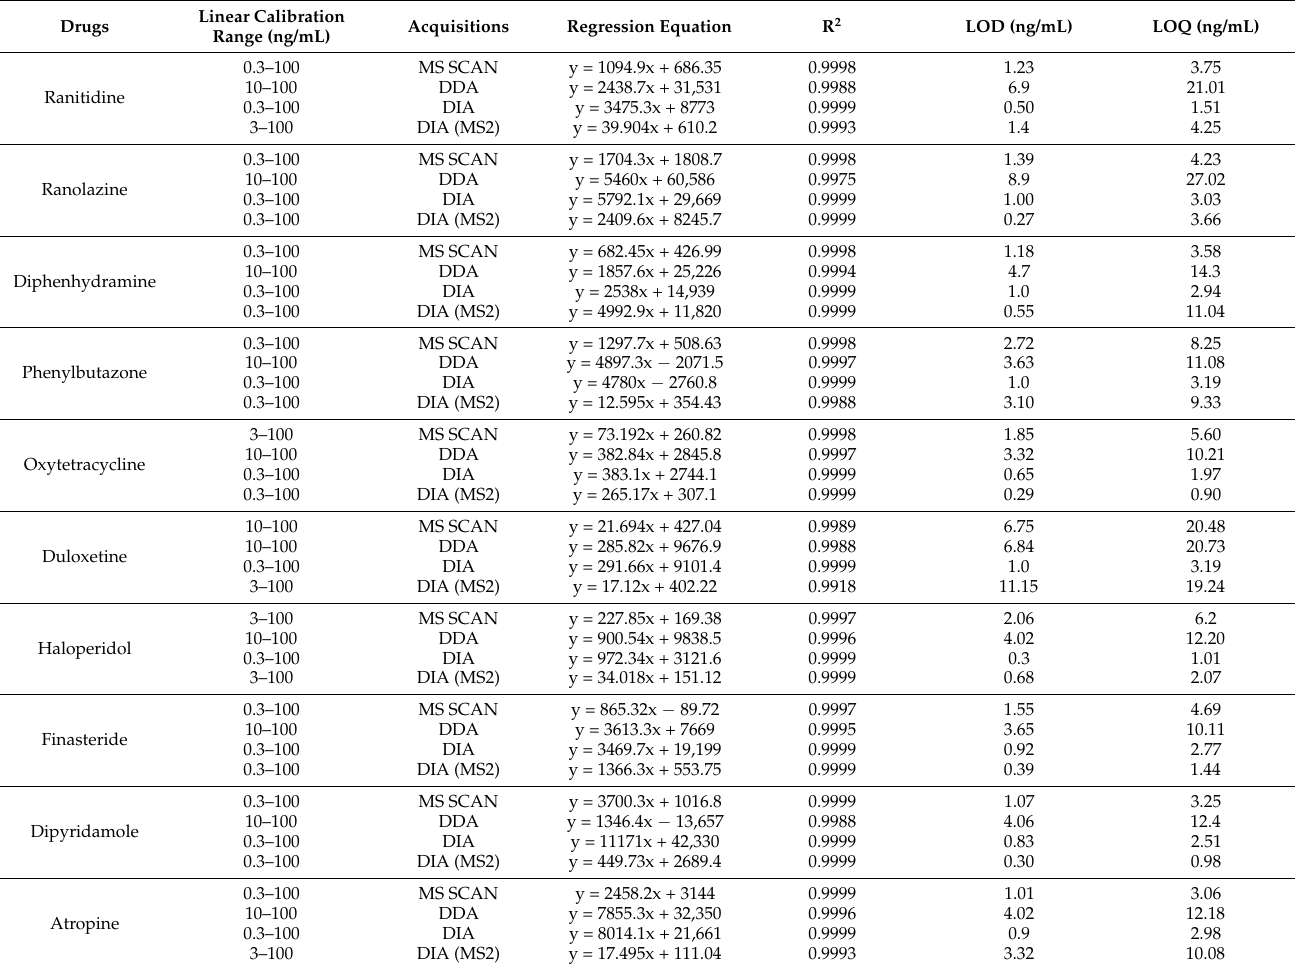
Table 1. Pharmaceutical drug quantification results by comparing LOD/LOQ for MS1 full-scan, DDA, and DIA modes on MS1 level and LOD/LOQ data of drugs on MS2 level in